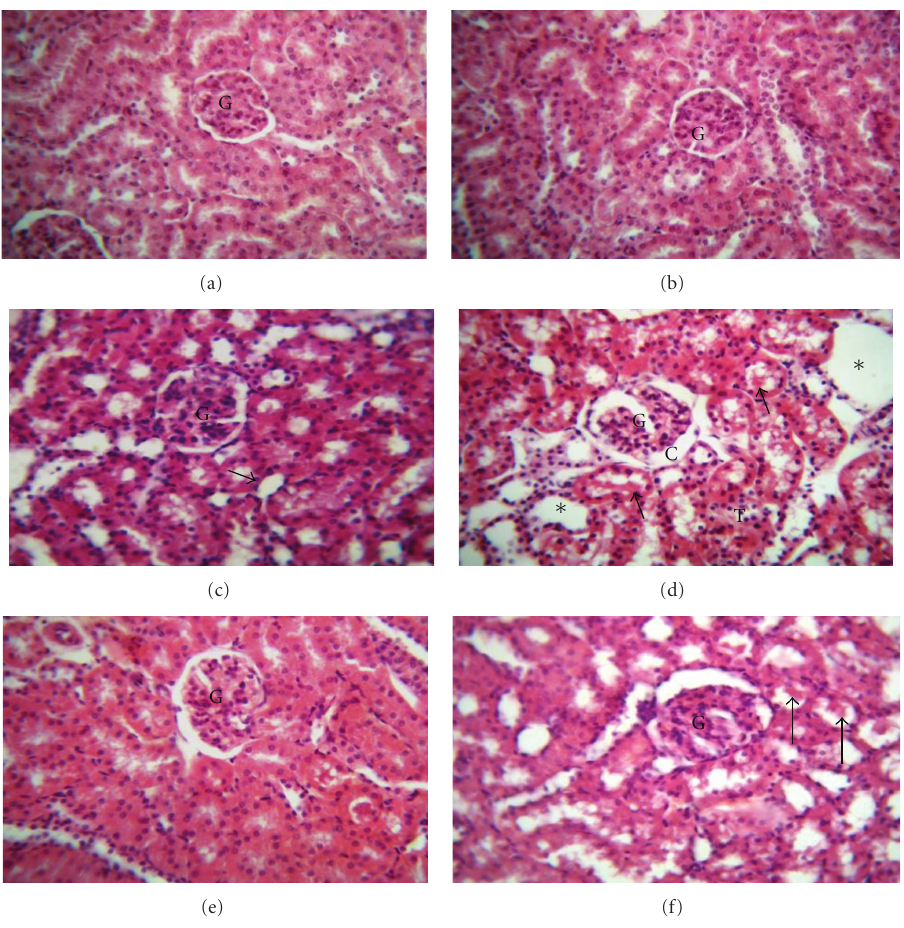
Figure 2: E ff ect of coenzyme Q10 (CoQ10) on kidney histopathological picture of doxorubicin- (Dox-) treated and untreated rats. A photomicrograph of a section in rat kidney (H and E × 400) of ((a) and (b)) untreated control and low dose CoQ10 treated (CoQ10L) groups, respectively, with normal structure of renal glomeruli (G) and cortical tubules; (c) high dose CoQ10 treated (CoQ10H) group with normal renal glomeruli (G), but mild degeneration of the epithelial lining of some tubules (arrow); (d) Dox-treated group with dilated Bowman’s space (c), severe degenerative changes observed in the renal tubules with exfoliated cells (T). Some tubules are filled with protein casts (arrows) and some showing cystic dilatation (stars); (e) Dox/CoQ10L group with regeneration of renal tubular epithelial cells and normal morphology of renal cortex and glomeruli (G); (f) Dox/CoQ10H group with marked degeneration of renal tubules with exfoliated epithelial cells and casts (arrows).